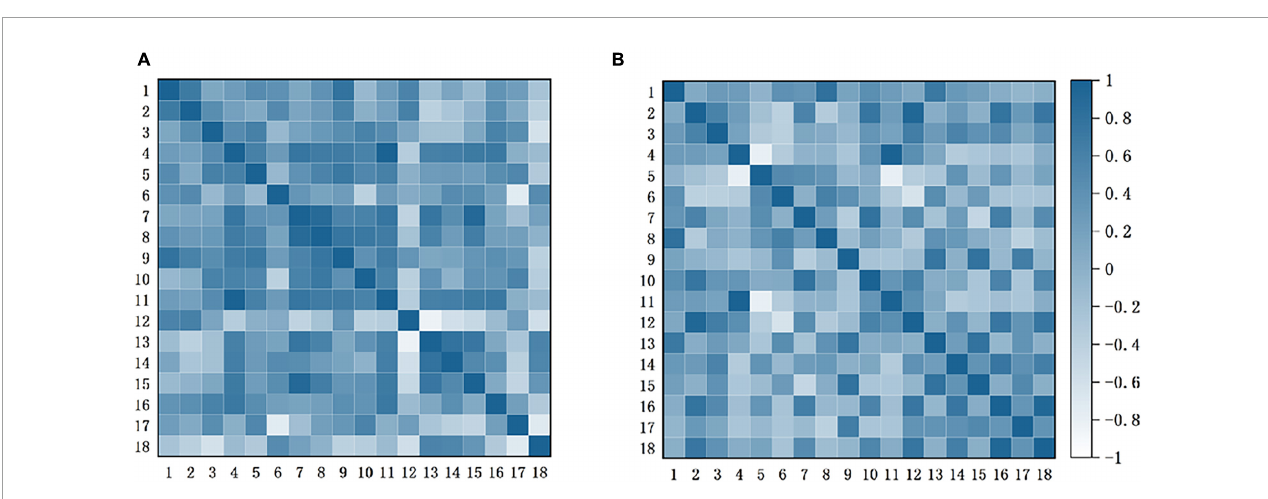
FIGURE6 Functional connection matrix for each channel with and without music intervention. (A) Without music intervention. (B) With music intervention. It presents the connectivity matrix heat map for the two conditions with and without music intervention, respectively. In this case, each pixel value in the 18 × 18 matrices corresponds to a value of the Pearson correlation coefficient, which is used to express the correlation between the